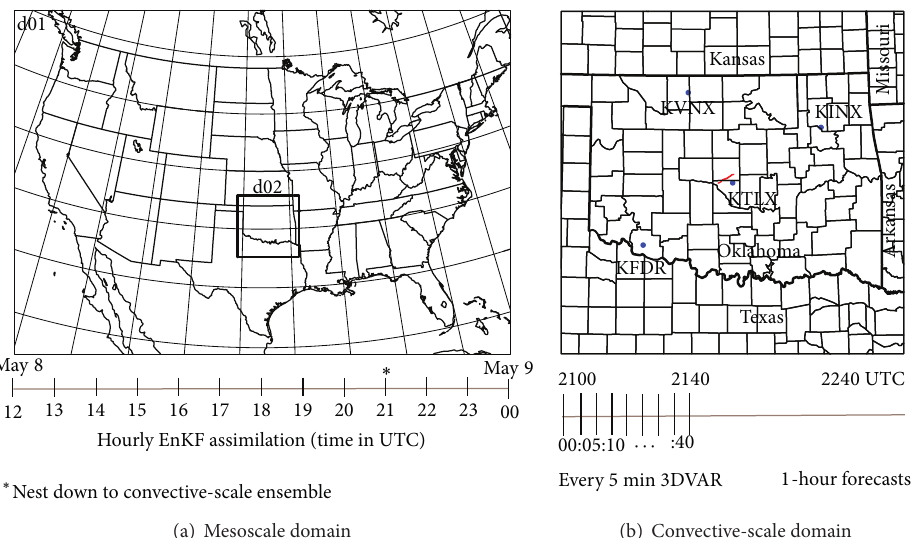
Figure 1: (a) The mesoscale domain (d01) covering the CONUS, the nested convective-scale domain (d02), and the time line of the hourly mesoscale data assimilation experiments; (b) the convective-scale domain with county borders (d02, enlarged), location of the four WSR-88D radars (blue dots), the NWS surveyed storm damage path (in red), and the time line of the convective-scale data assimilation and forecast